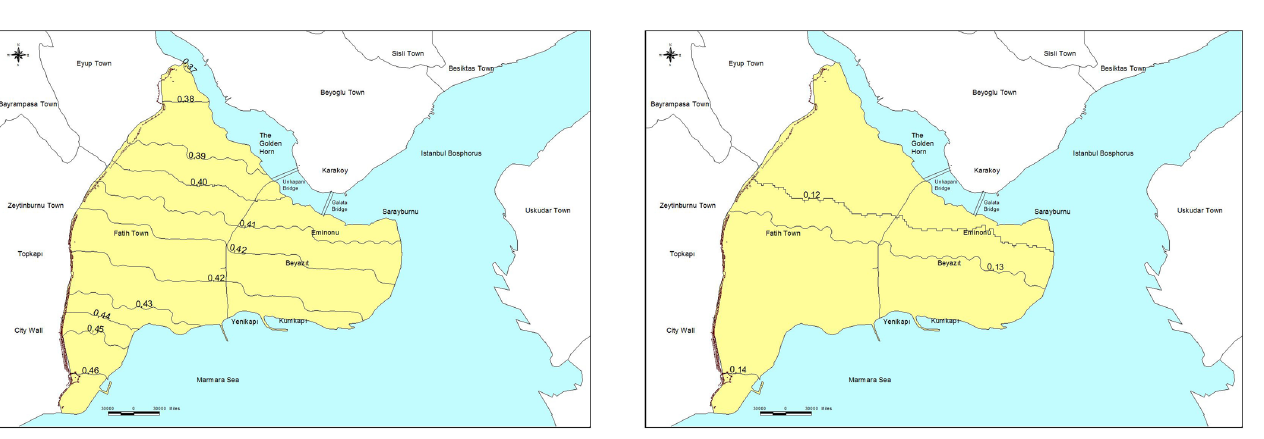
Fig. 15. SA ( T = 1.0s) contour for a 40% probability of ex- ceedance in 50yr for for the historical penninsula of Istanbul (Pois- sonian model) (˙Ince,